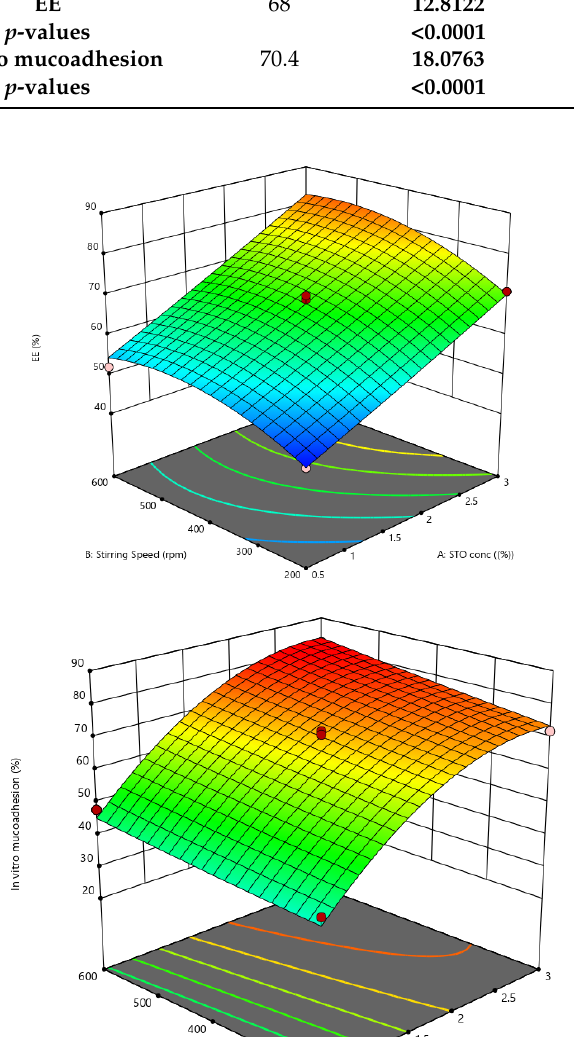
Figure 3. Response surface graphs for EE and in vitro mucoadhesion (3-dimensional and contour).